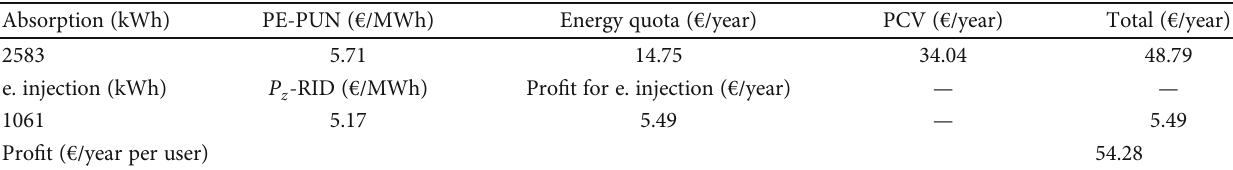
Table 7: Yearly CEP pro fi t for single end-user (2017).